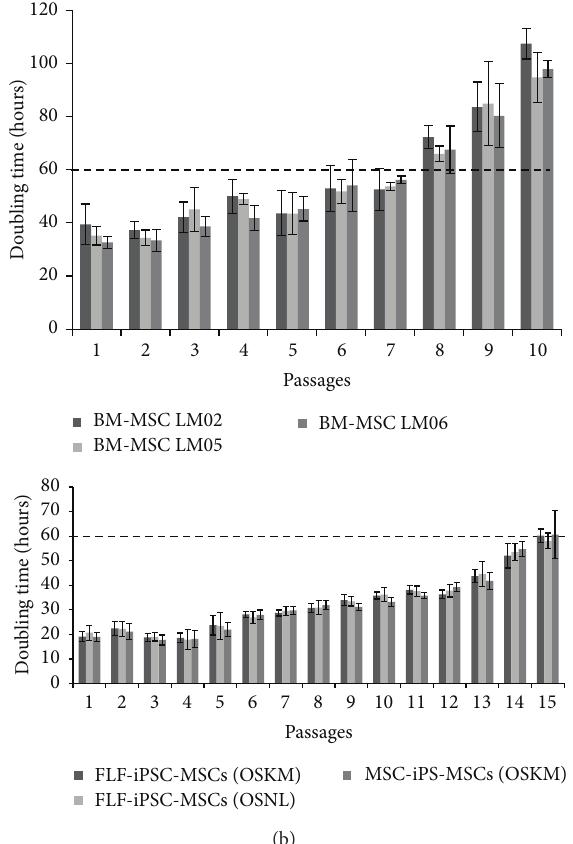
Figure 3: Antigen phenotype, proliferation rate, and functional characterization of hiPSC-MSCs. (a) Immunophenotype of the three hiPS- MSCs lines generated. Representative flow cytometry analysis of hBM-MSCs, FLF-iPSC-MSCs (OSKM), FLF-iPSC-MSCs (OSNL), MSC- iPSC-MSCs (OSKM), and MSC-derived iPSC line MSC-related markers CD73, CD90, and CD105 and hematopoietic CD45, CD34, and CD19 were assessed (solid histogram). (b) In vitro cell growth, measured as cumulative population of hiPSC-MSCs and BM-MSCs derived from 3 different donors (LM02, LM05, and